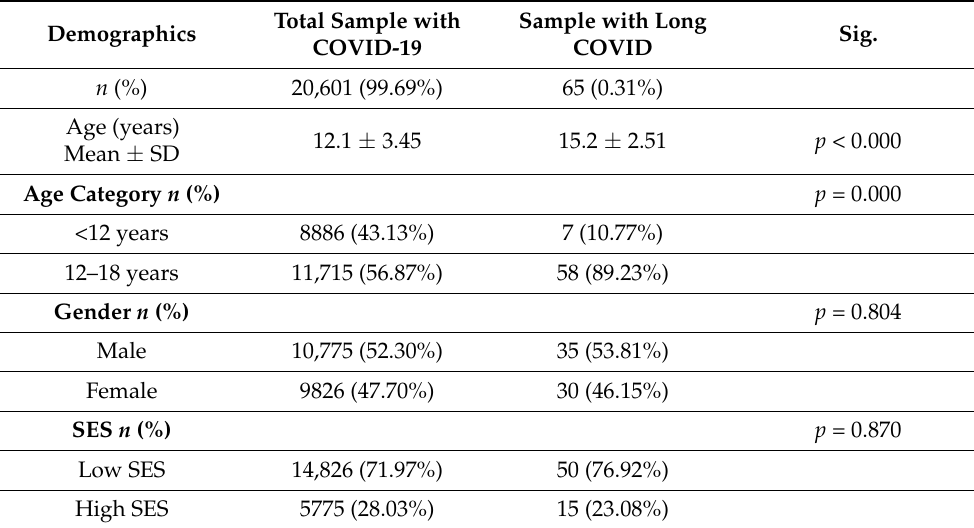
Table 1. Demographic characteristics of the study sample ( n = 20,601).